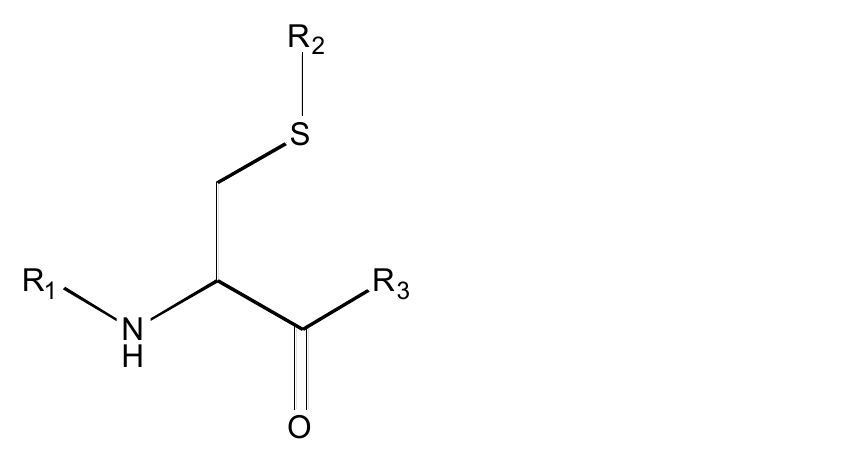
Figure 1. Basic structure of cysteine diazomethyl- and chloromethyl-ketone derivatives. Table 1 lists the vector of properties of cysteine diazomethyl- and chloromethyl-ketone derivatives and experimental data of antileukemic activity (IC 50 ) and stability k